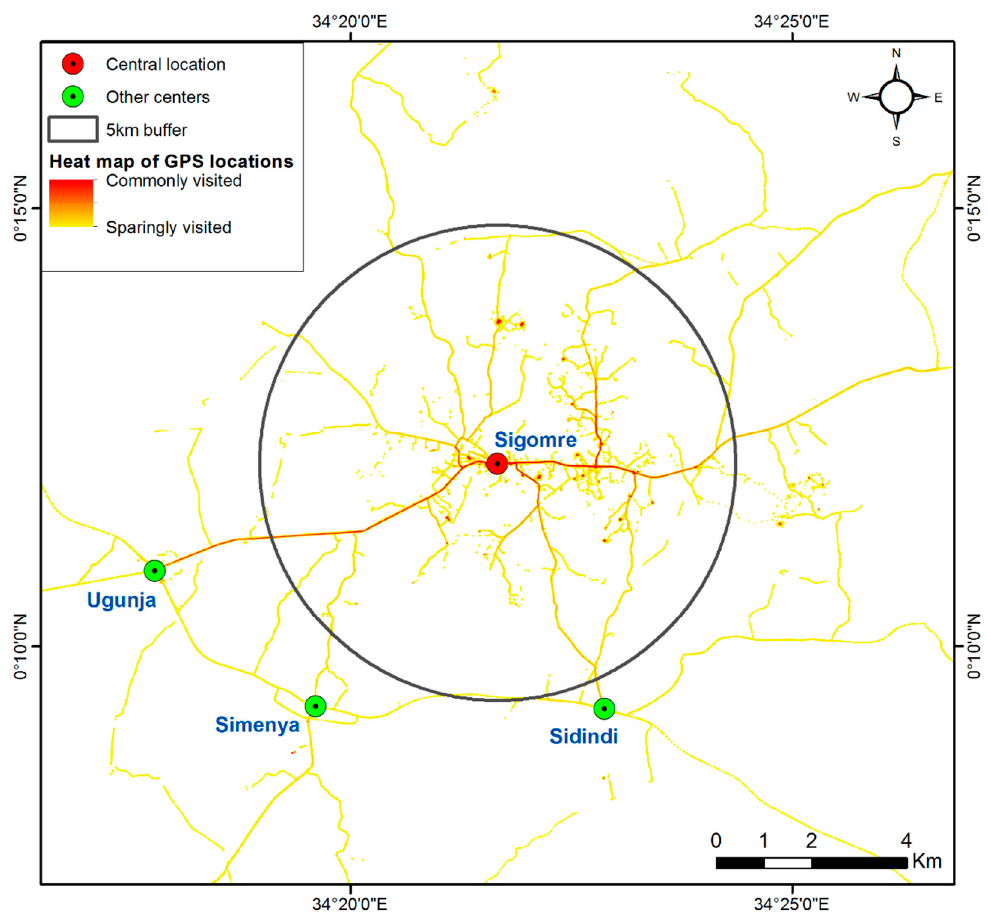
Figure 6. Traces of road network as visualized from the heat map resulting from the GPS traces of motorcycle taxis.